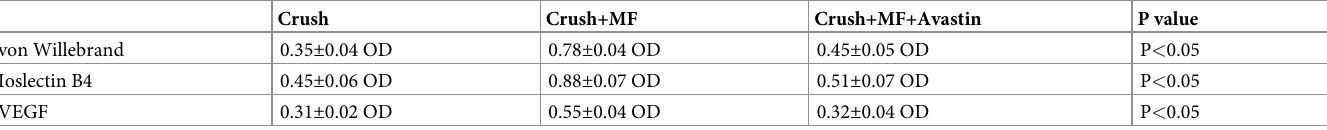
Table 4. ELISA analysis of angiogenic factors of nerve wrapped by the muscle flap. Crush Crush+MF Crush+MF+Avastin P